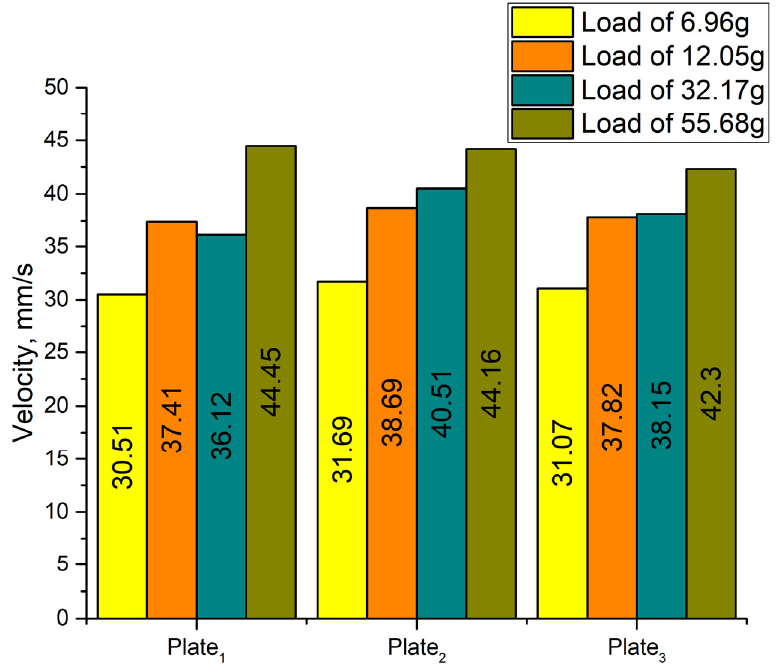
Figure 17. Summary of maximum velocity values at different load conditions.